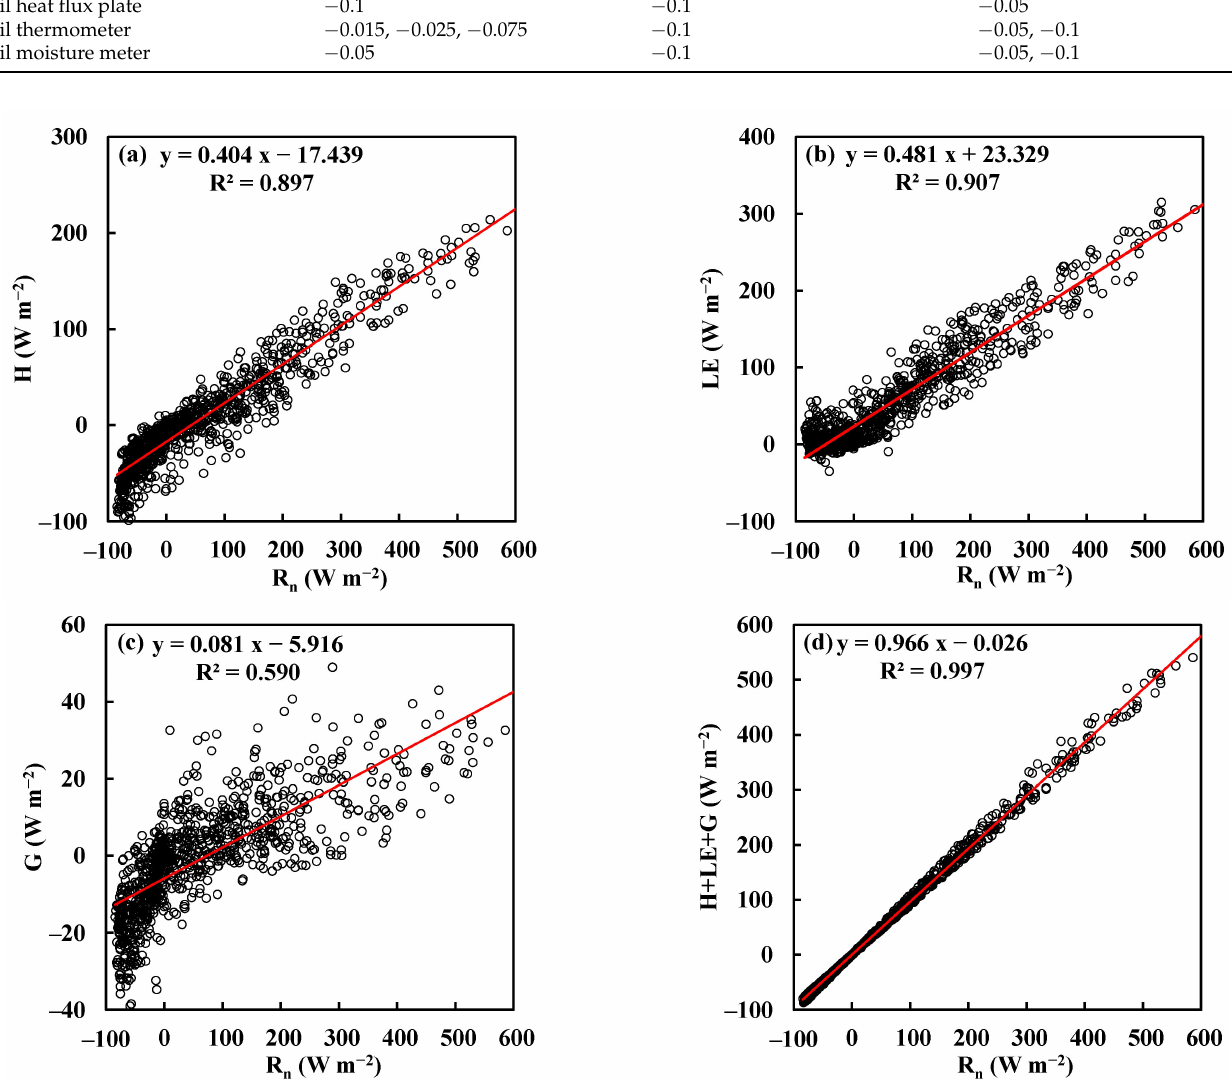
Figure 1. Scatter plots between R n and H ( a ), LE ( b ), G ( c ), and H+LE+G ( d ) above the